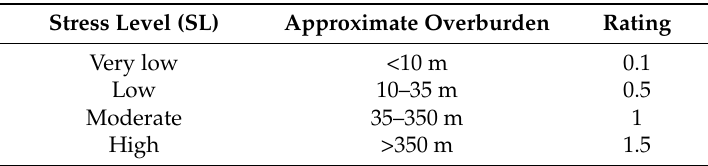
Table 6. Stress levels and their ratings per RMi system.